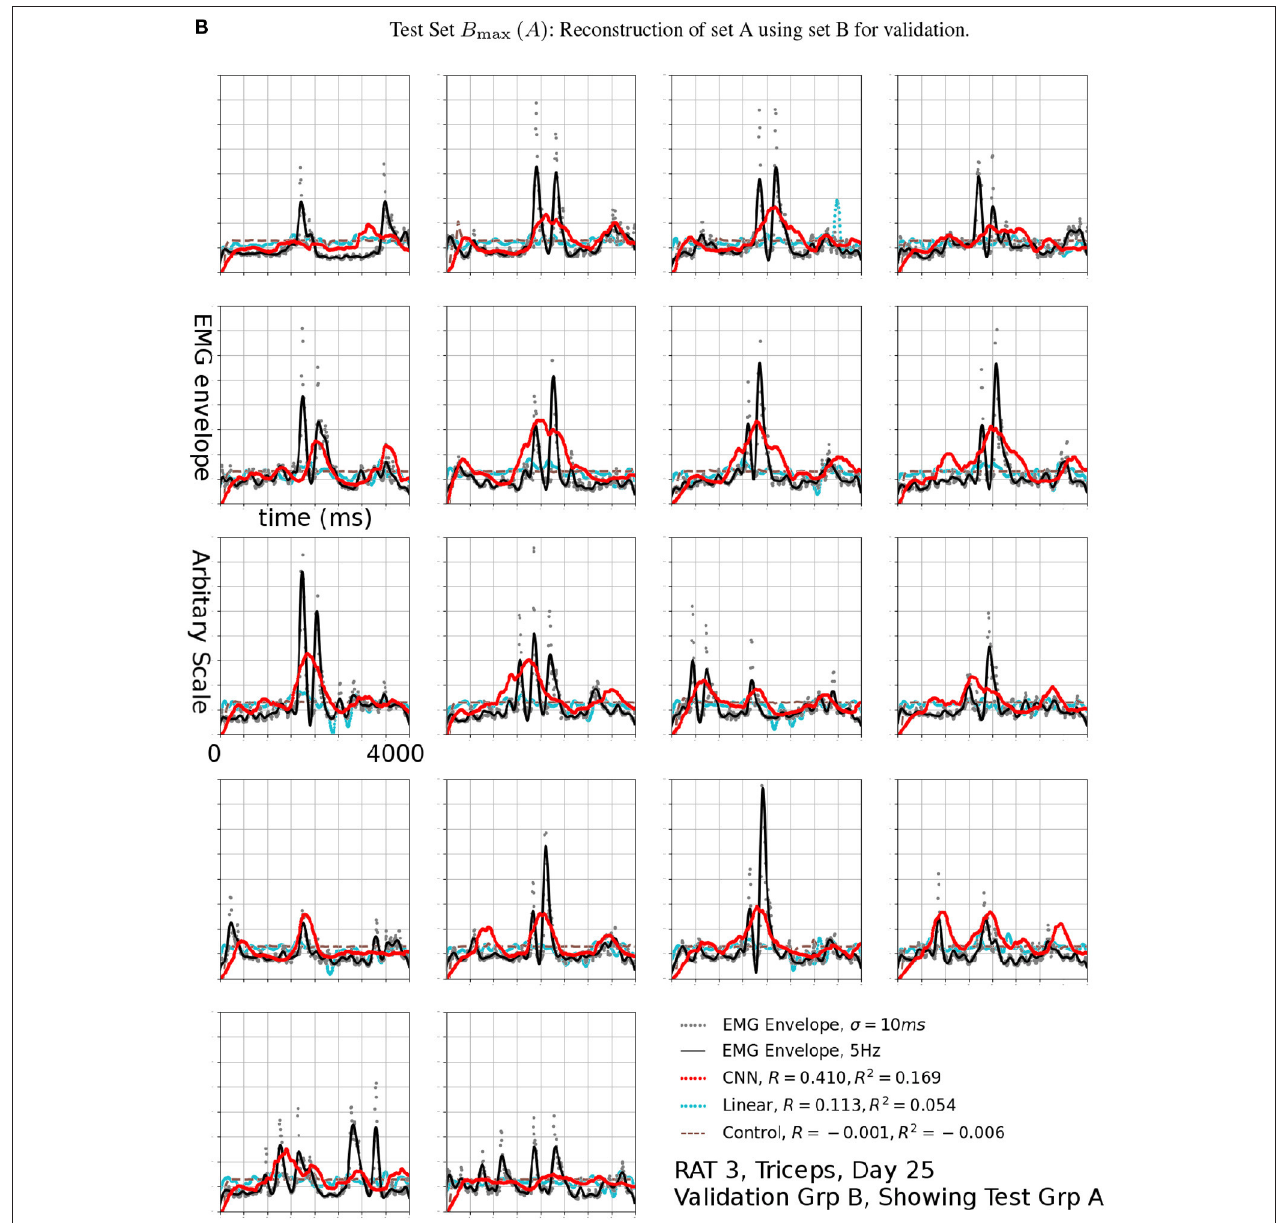
FIGURE 7 | Reconstruction (Red, CNN; Cyan: Linear; Brown Dashed: Scrambled CNN Control) of low-pass filtered EMG signals (Black lines) from neural signals. Original EMG envelopes without low-pass filtering were drawn in gray dots for reference. This signal was marked by a black arrow in 6b. Scrambled Control (Brown): Training was carried out on scrambled singals, producing predictions that are essentially flat after the first transient. Horizontal axis: Time bins of 10 ms, each trial is 4 s long. This duration is identical for Figures 7 , 9 .